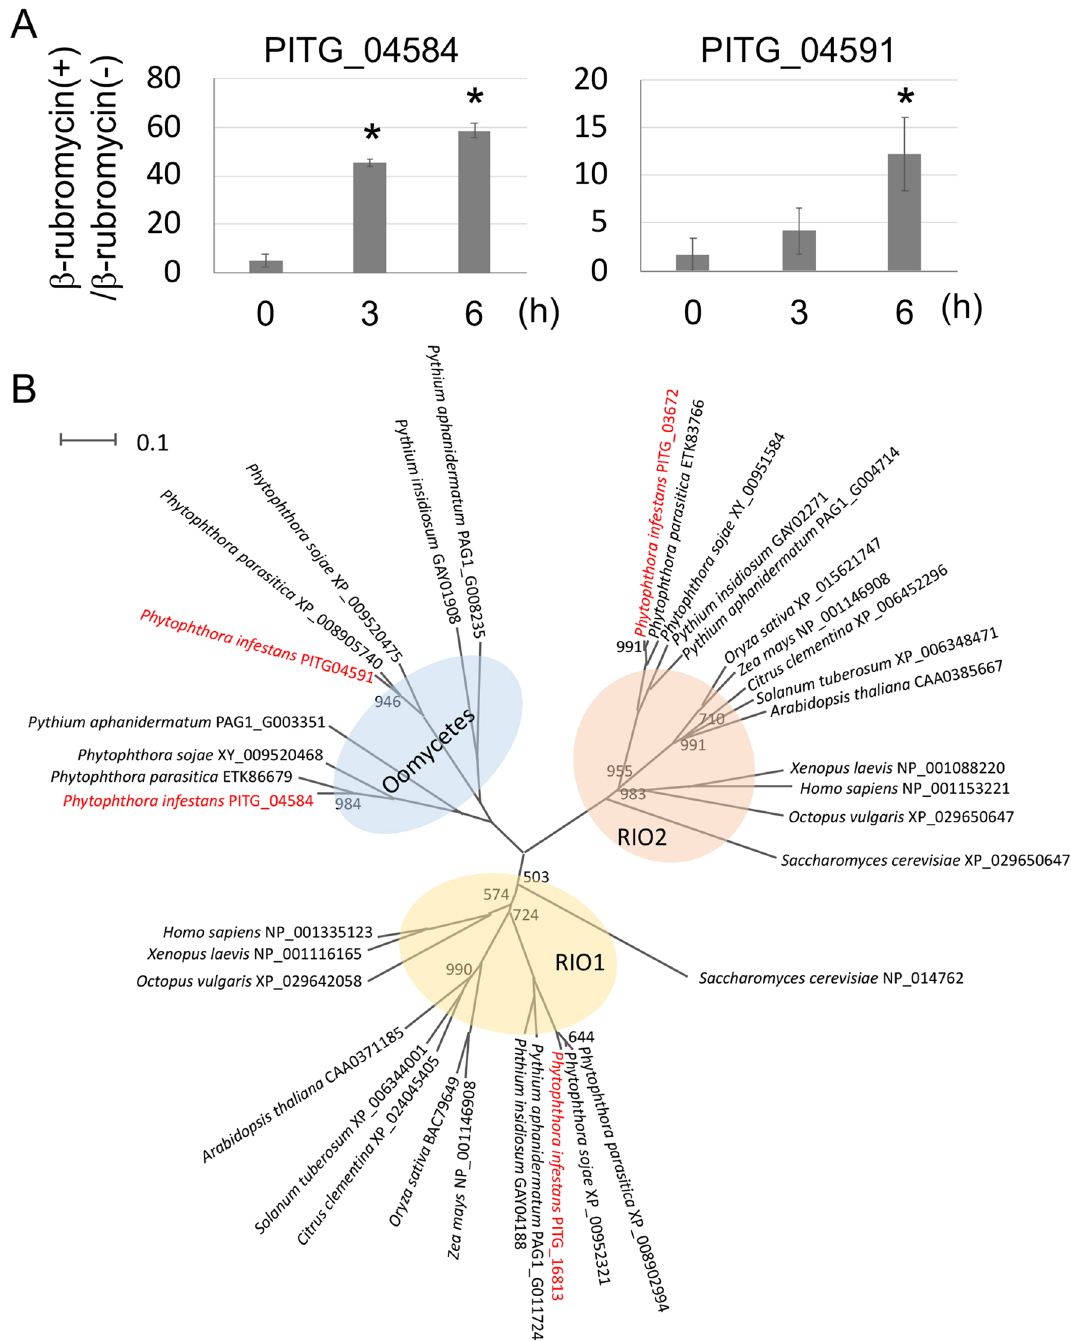
Figure 5. Expression and phylogenetic analyses of RIO kinase-like genes. ( A ) qRT-PCR of PITG_04584 and PITG_04591 expression in Ph. infestans with or without 1.0 mg/L β-rubromycin. Fold expression corresponds to the ratio of the mean expression levels of their genes in the presence of 1.0 mg/L β-rubromycin divided by those without β-rubromycin. The relative transcription levels are the means of at least three independent experiments, and the error bars indicate standard deviations. * p < 0.05, Student’s t-test. ( B ) The phylogenetic relationship of RIO kinase orthologs. Built is a consensus neighbor-joining tree based on sequences orthologous to PITG_04584, PITG_04591, PITG_03672, and PITG_16813, based on an alignment performed using ClustalW. The individual nodes of resulting trees was examined with 1000 bootstrap replicates; only values below 1000 are